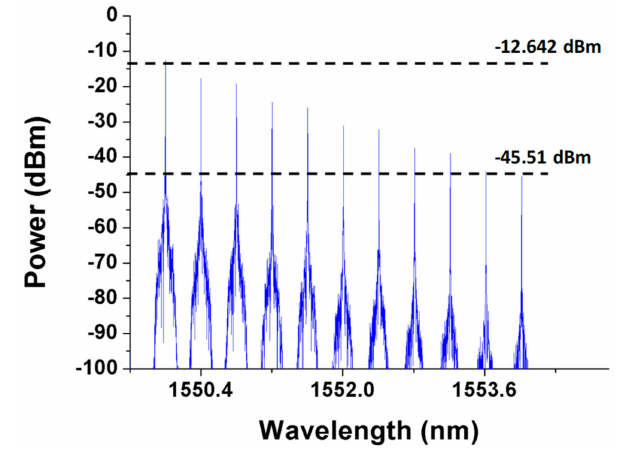
Figure 5. Detection signals received by the central o ffi ce (CO) when no breakpoint is present in the transport